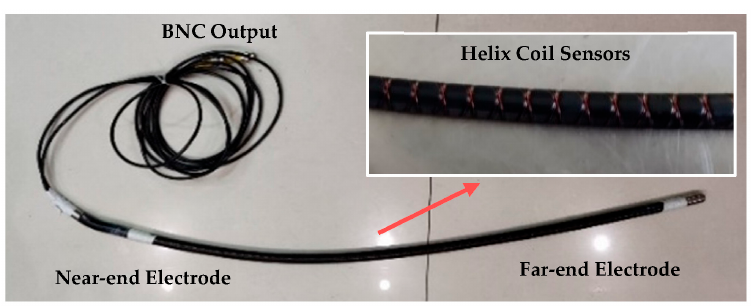
Figure 4. Experimental section of the towed antenna.